Question: Write the caption for this figure.
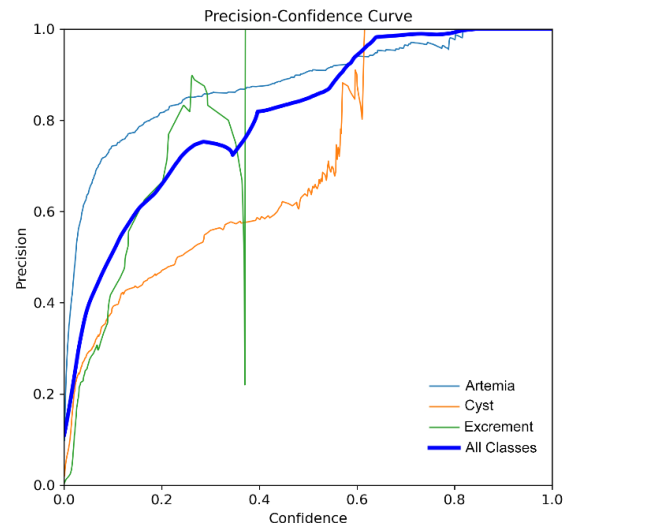
Answer: YOLOv5 Precision - confidence curve